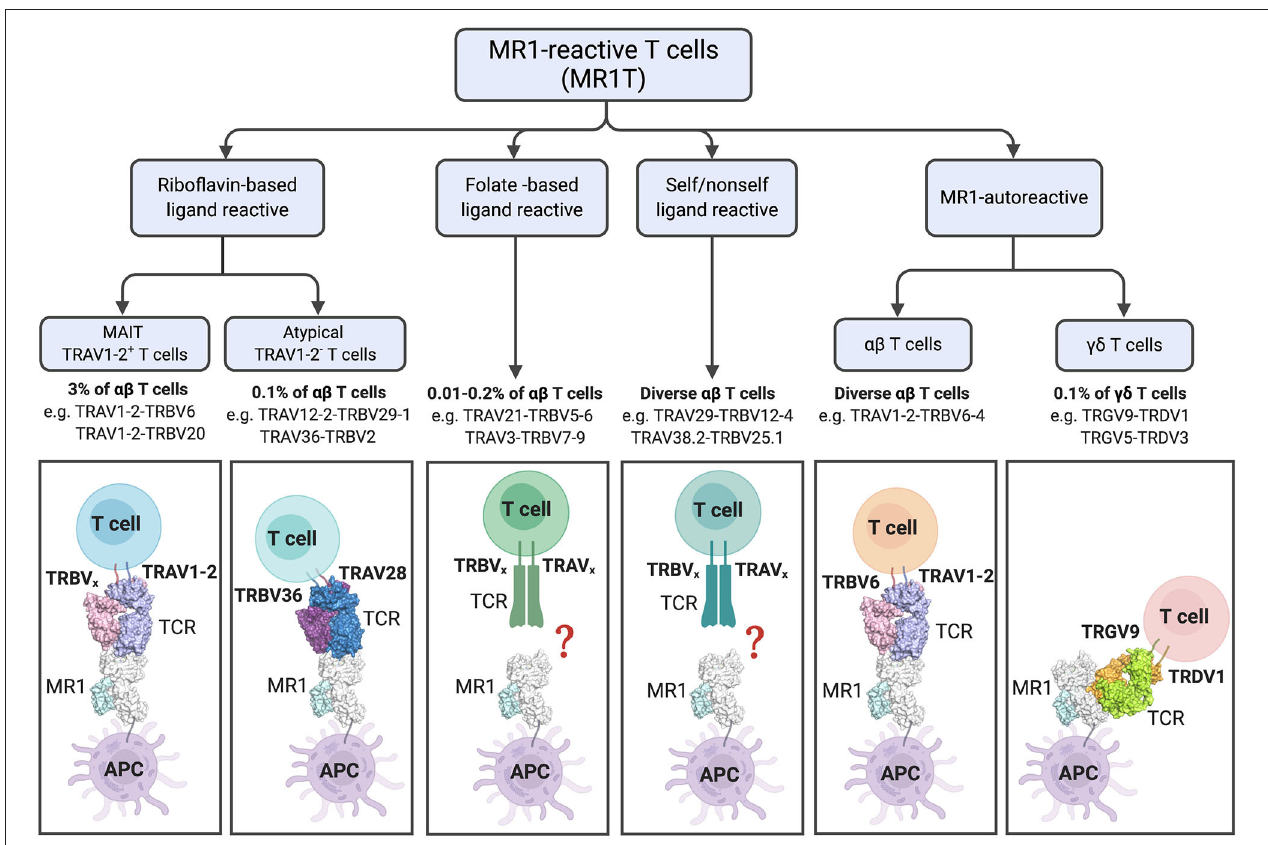
FIGURE 3 | Diversity and characteristics of MR1-reactive T cells. % refer to those reported in human PBMCs. For subsets with diverse TCRs examples are listed. The lower panel shows cartoon representations of the crystal structures of ternary TCR-MR1-Ag complexes: The typical MAIT A-F7 TRAV1-2-TRBV6-1 TCR-MR1-5-OP-RU (PDB; 6PUC); the atypical TRAV36-TRBV28 TCR-MR1-5-OP-RU (PDB; 5D7L); MR1-autorective M33.64 (TRAV1-2/TRBV6-4) TCR-MR1-5-OP-RU (PDB; 5D5M); and G7 γδ TCR with MR1-5-OP-RU complex (PDB; 6MWR). The MR1 and β 2-microglobulin molecules are colored white and pale-cyan, respectively. TRAV1-2 TCR α , light-blue; TRAV6 TCR β , light-pink; TRAV36 TCR α , violet-purple; TRBV28 TCR β , sky-blue; TRGV9 TCR γ ; lemon, TRDV1 TCR δ , orange. Structural illustration was created using PyMOL Molecular Graphics System, Version 1.8.6, Schrodinger and